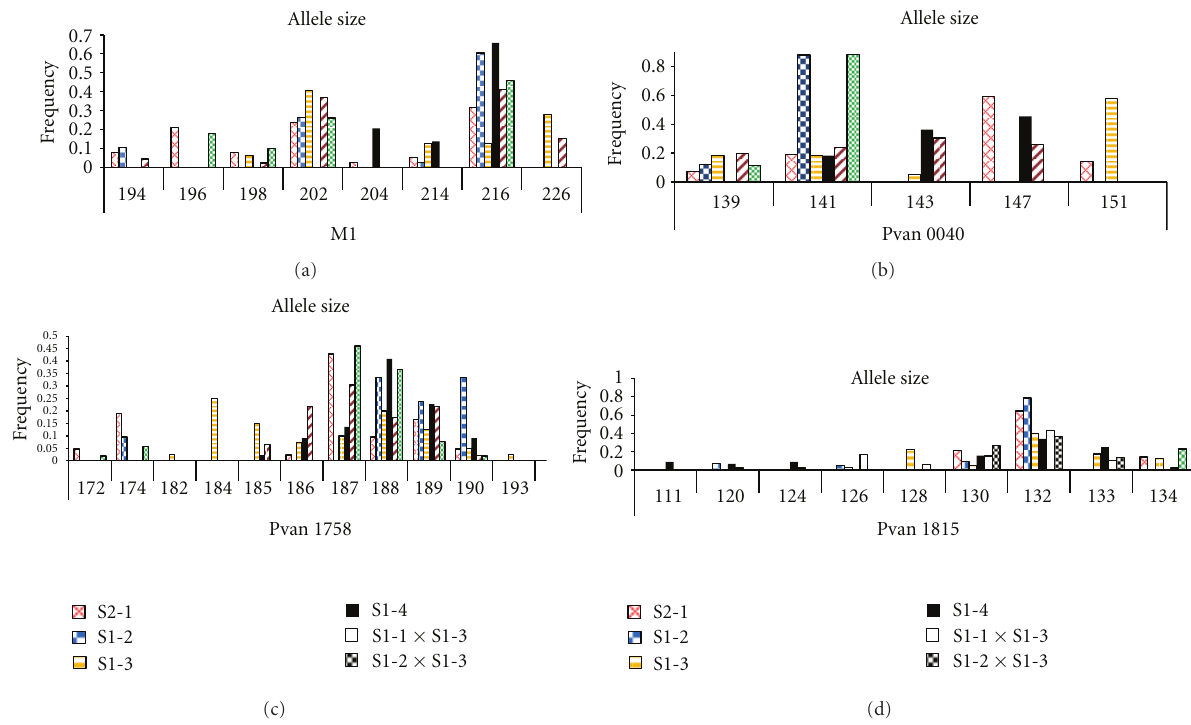
Figure 1: Allelic frequencies of loci M-1 [11], Pvan 0040, Pvan 1758 and, Pvan 1815 [12] for six L. vannamei stocks used for aquaculture in Cuba.